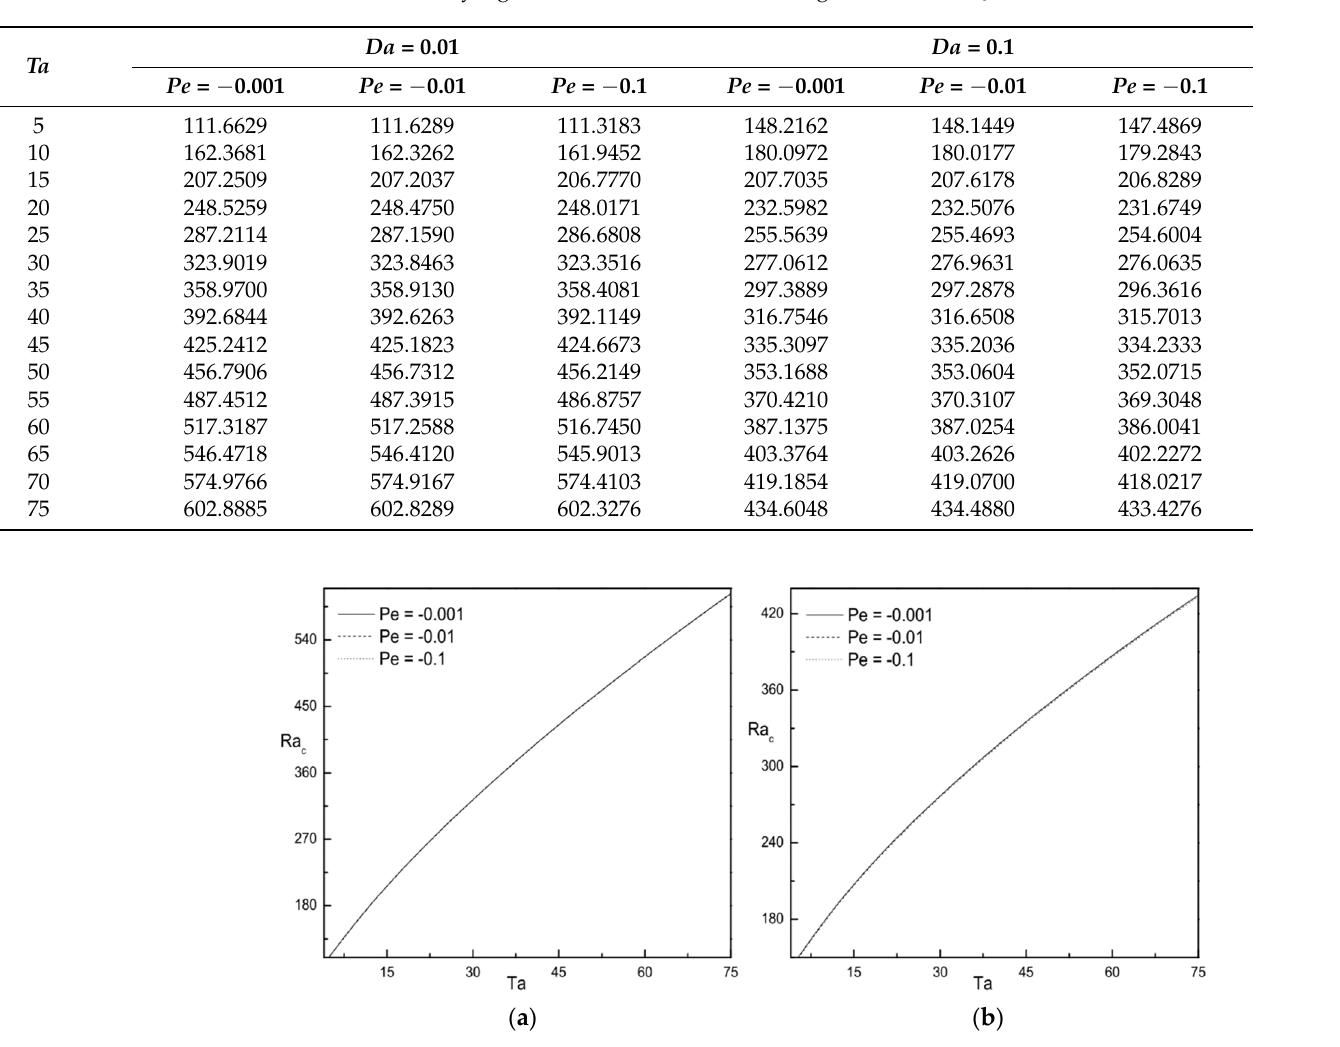
Table 6. Critical Rayleigh number for downward throughflow fixed at Q = 2.